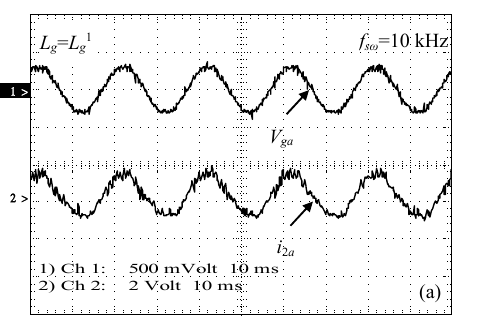
Figure 15. High frequency spectra of ( a ) power converter current ( b) grid current.